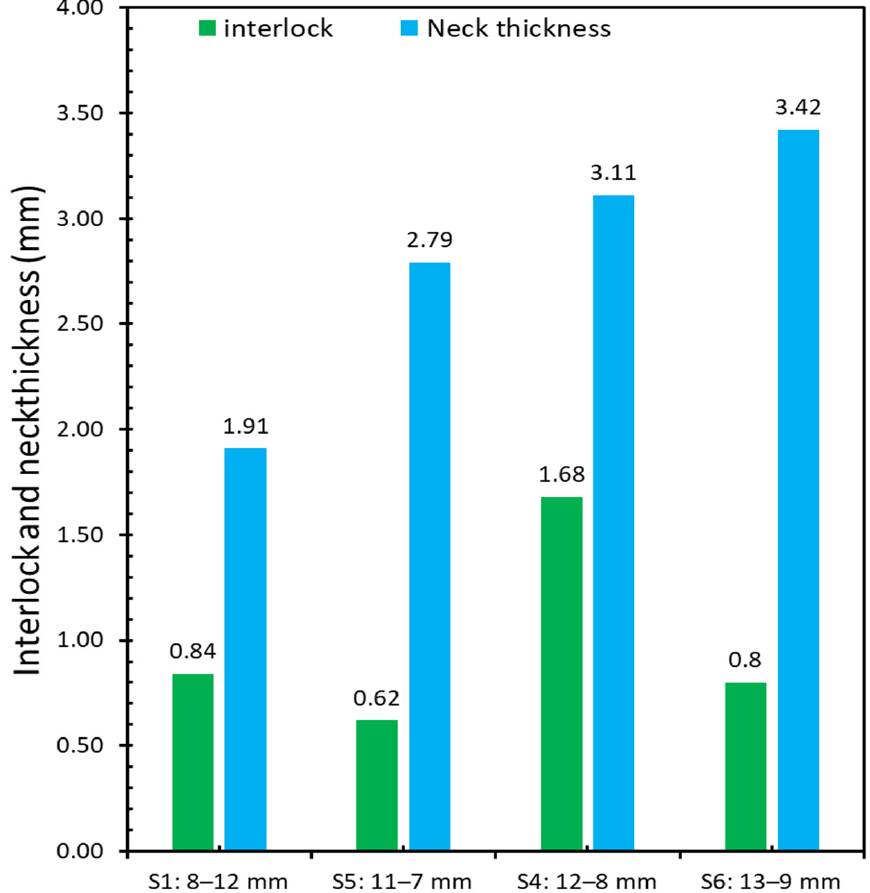
Figure 19. Comparison of interlock and neck thickness between S1, S4, S5 and S6.